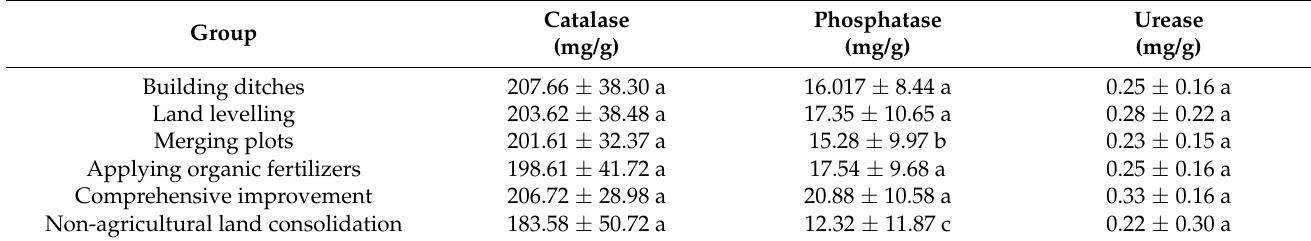
Table 4. Three soil enzyme activities in the study